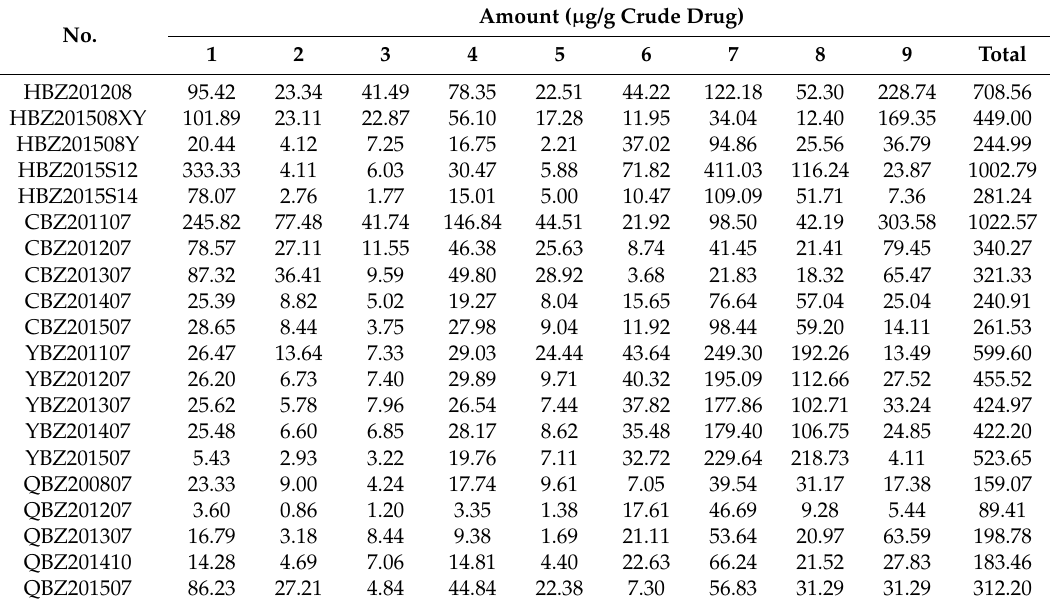
Table 5. Determination of the nine analytes in different batches of Angelicae Dahuricae Radix.